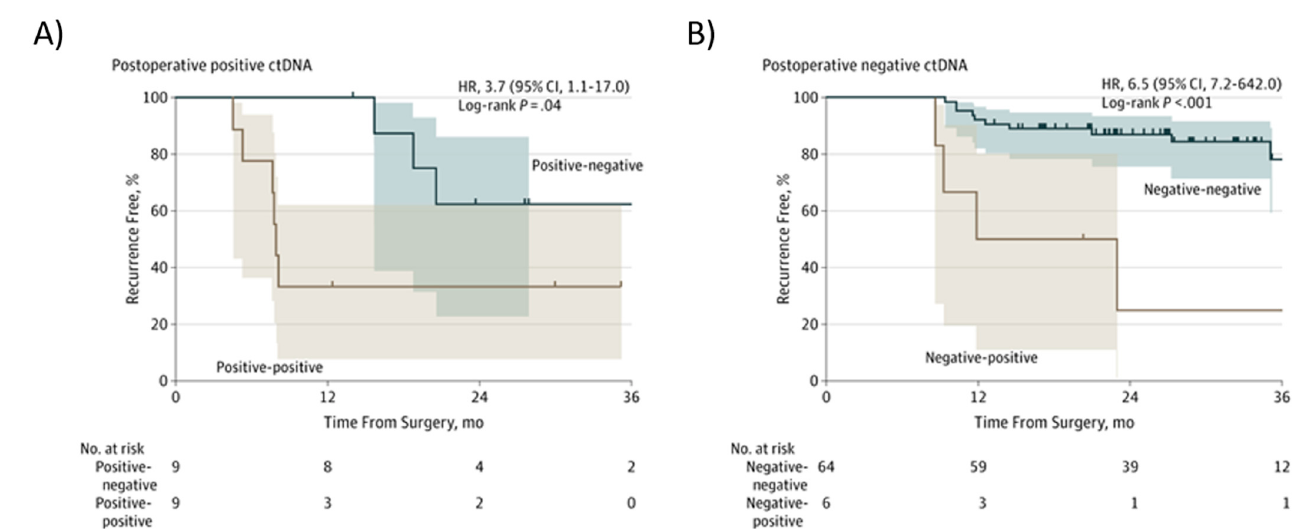
Figure 6. Kaplan–Meier estimates of recurrence-free interval according to ctDNA in stage III colon cancer patients after chemotherapy. ( A ) Postoperative positive ctDNA; ( B ) Postoperative negative ctDNA. From Tie et al. [123].